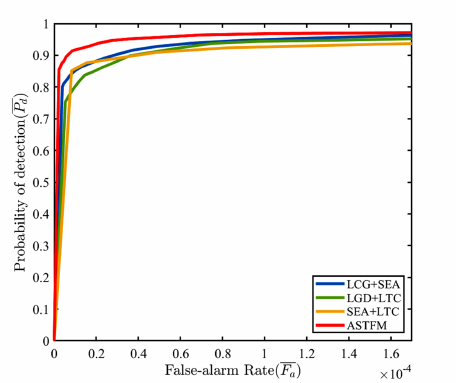
Figure 11. ( a – f ) ROC curves of different methods on Seq.1–6, respectively.